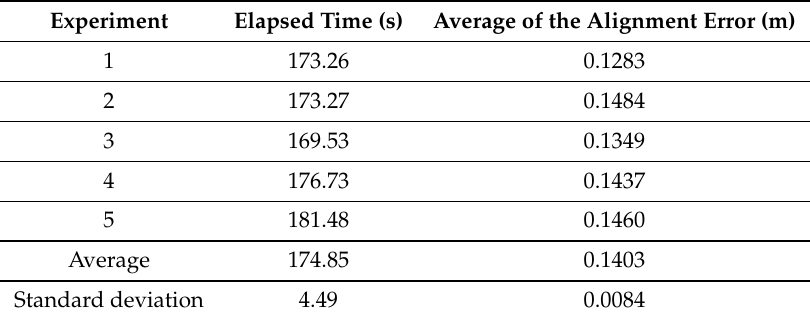
Table 5. Manual Mode Experiments.